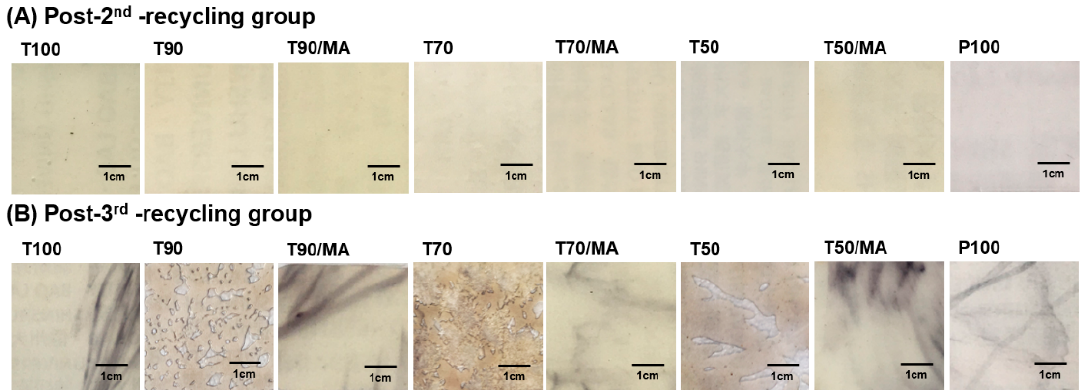
Figure 2. Surface observation of T / P and T / P / MA blends as related to post-2nd and post-3rd recycling. ( A ) Post-2nd-recycling group; ( B ) post-3rd-recycling